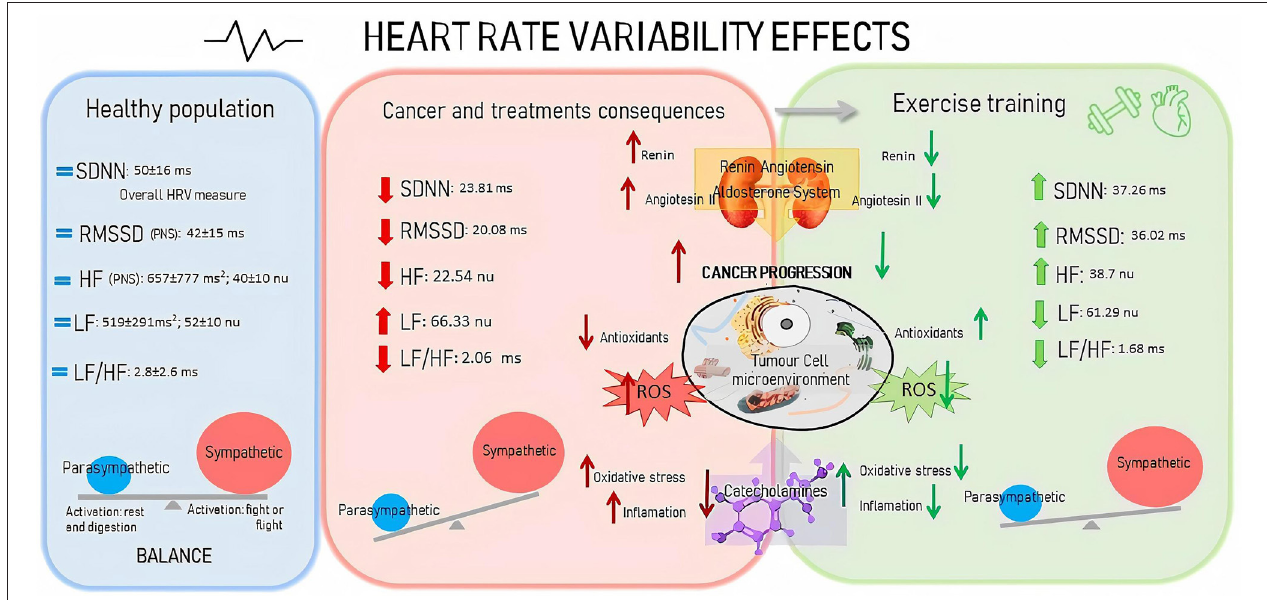
FIGURE 7 | Explication of the changes in the heart rate variability of cancer patients and exercise training effects in comparation to healthy population data. Healthy population of HRV data from Nunan et al. (2010), cancer and treatments consequences and exercise effects data correspond to control and exercise group after intervention results of the current systematic review. References from the physiological changes in cancer patients and its exercise effects are reported in the systematic review discussion. SDNN, standard deviation of the interbeat interval of normal sinus beats; RMSSD, root mean square of successive RR interval measures; HF, high frequency; LF, low frequency; LF/HF, low-to-high frequency ratio; PNS, parasympathetic nervous system; ROS, reactive oxygen